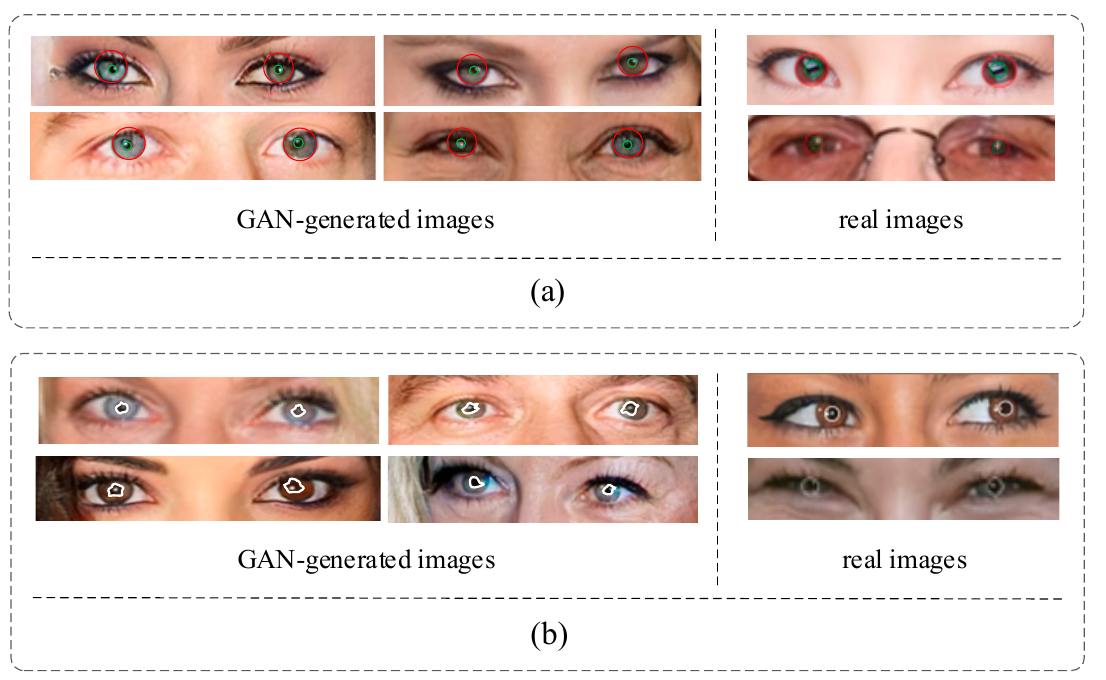
Figure 4. The example of the iris color and pupil boundary in real and GAN-generated images. ( a ) iris color. ( b ) pupil boundary.